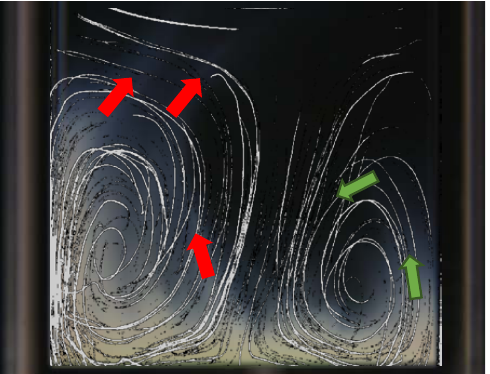
Figure 5. The streaming pattern inside the 1 wt% PNIPAM solution due to 2.5 MHz ultrasound waves, visualized by the polystyrene particles’ trajectory. The red arrows show the discrepancy between the turbidity evolution pattern (at 65 s) and the trajectory of particles (before the turbidity starts), whereas the green arrows show their congruency.